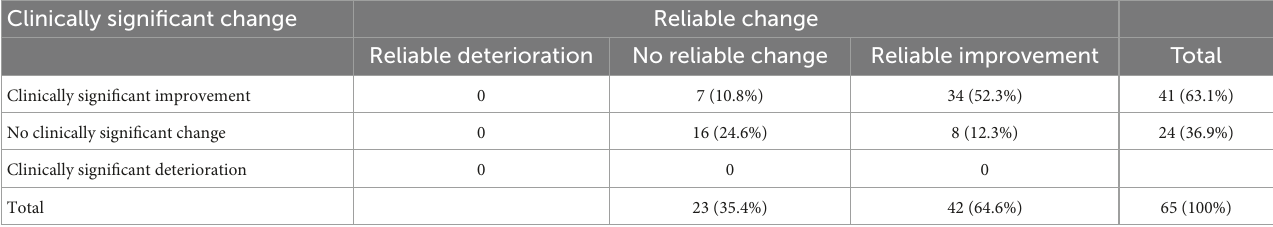
TABLE 4 Reliable and clinically significant change of the clinical sample at baseline.